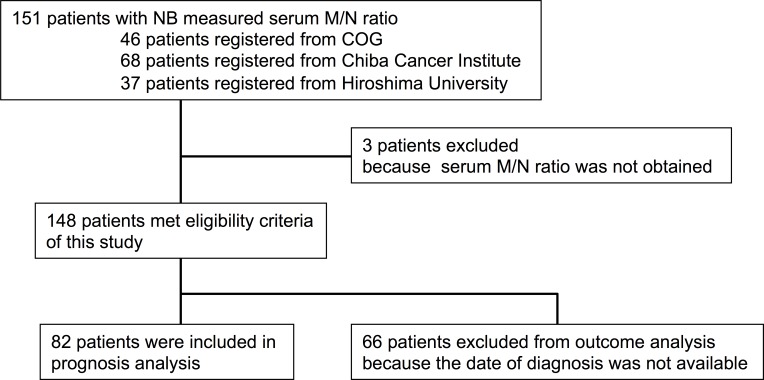
Patient disposition.